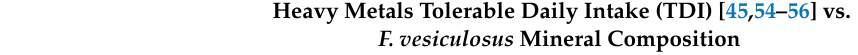
Table 4. Heavy metals detected in F. vesiculosus compared against tolerable intakes defined by EFSA and WHO. b.w.: body weight; UL: Upper Intake